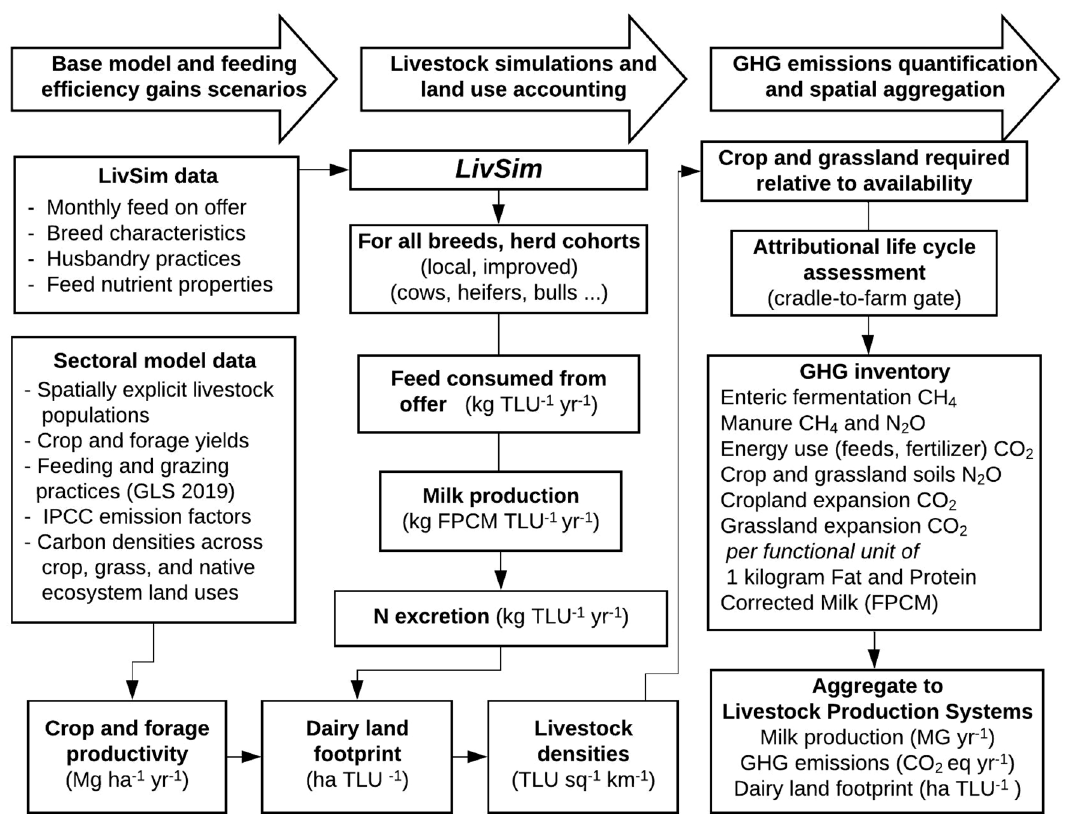
Figure 1. Analytical framework. A dynamic livestock simulation model (LivSim) is linked to an attributional life cycle assessment (LCA) and a spatial aggregation procedure to quantify GHG emissions per kilogram of fat and protein corrected milk